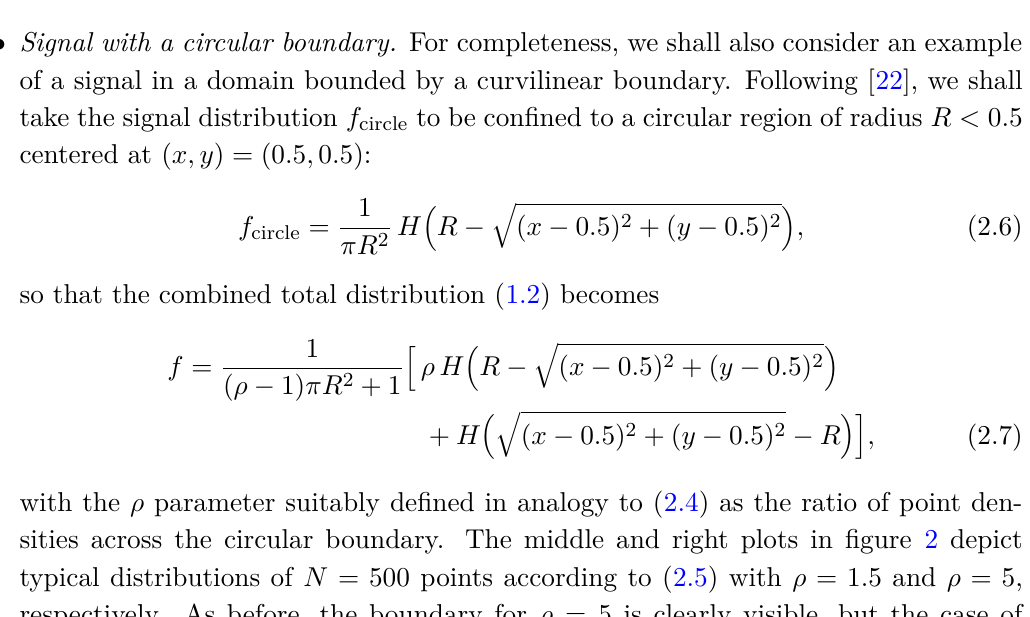
Figure 2 . The same as figure 1, but for the circular signal (2.6) with R = 0 . 25